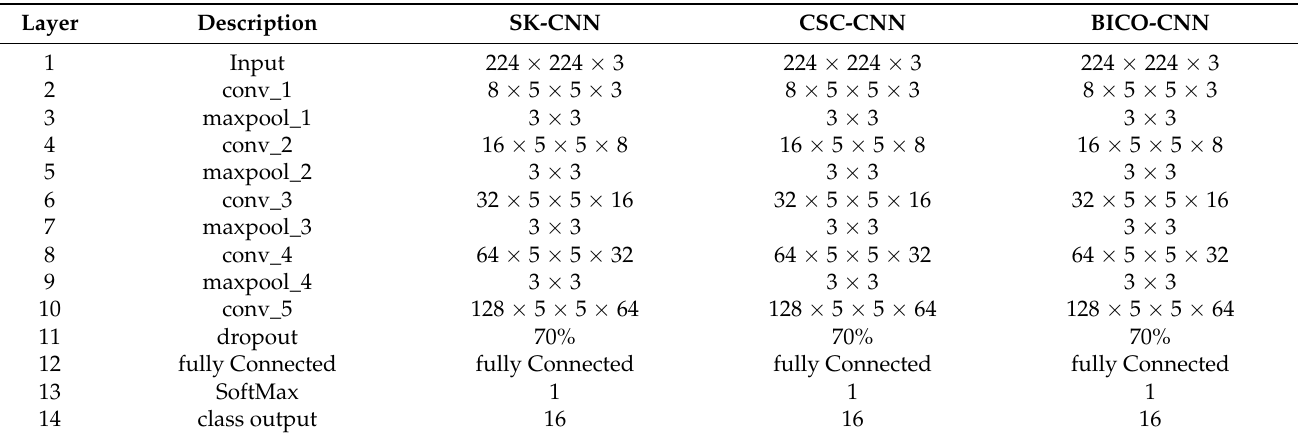
Table 4. Topology of the base